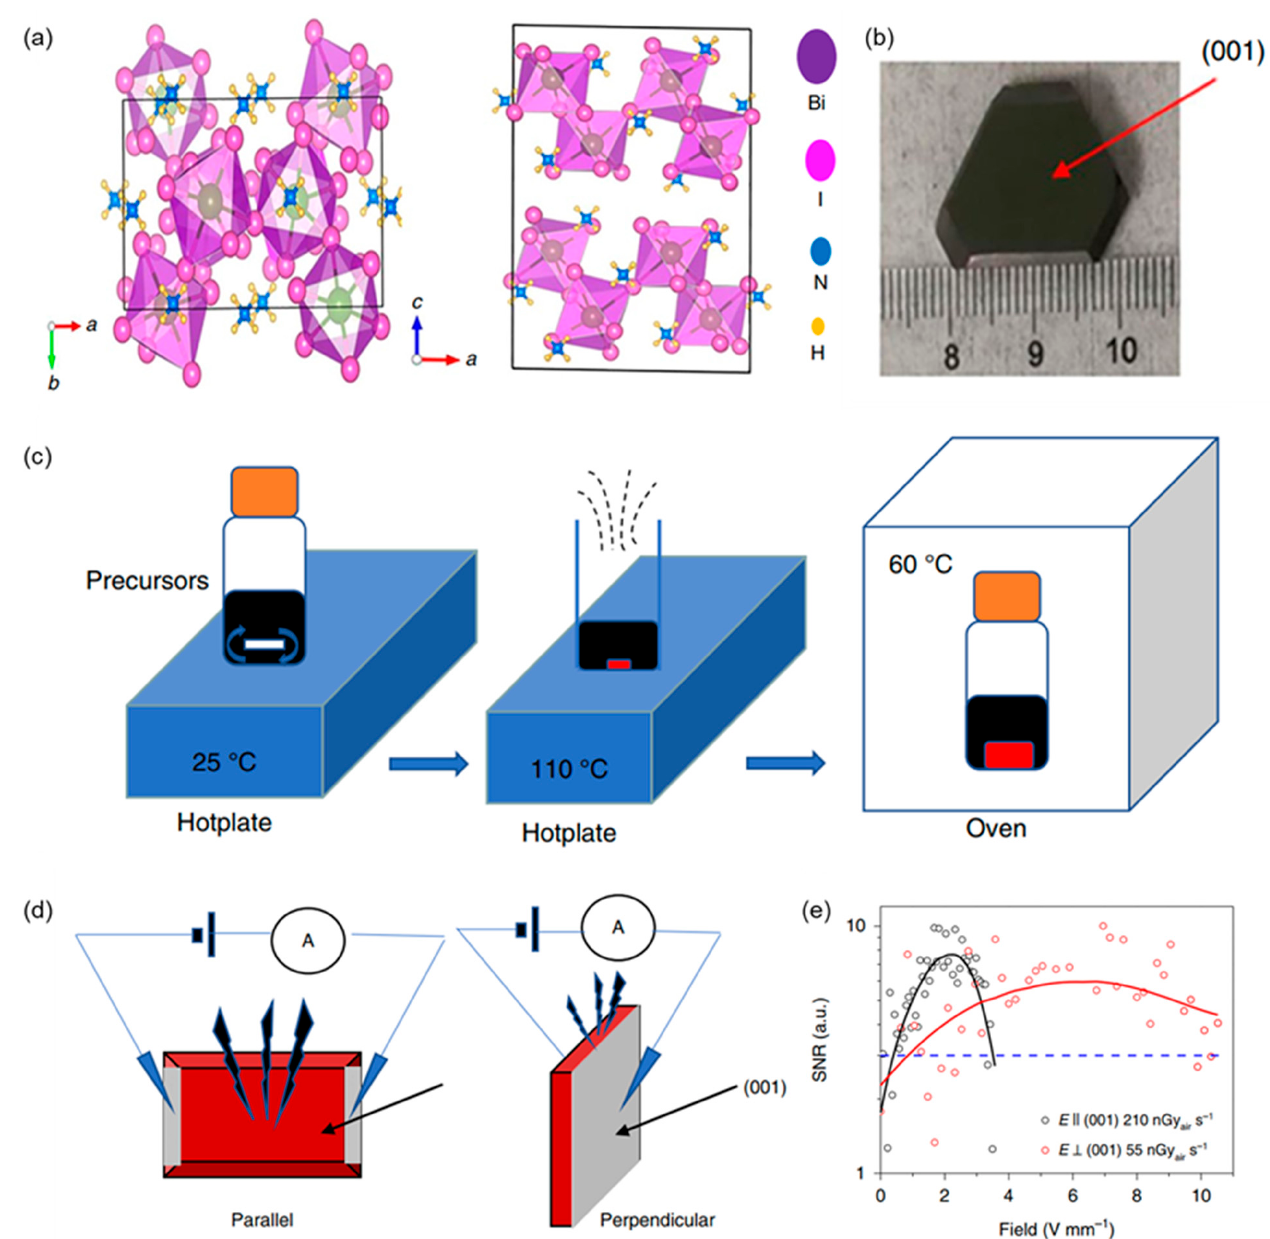
Figure 6. Low-dimensional organic–inorganic hybrid perovskites-based X-ray detectors. Reprinted with permission from Ref. [56]. 2019, Springer Nature. ( a ) Crystal structure of (NH 4 ) 3 Bi 2 l 9 along the c and b axes. ( b ) Photograph of a bulk (NH 4 ) 3 Bi 2 I 9 single crystal. ( c ) Procedure for crystal growth. ( d ) Illustration of parallel and perpendicular device structures. ( e ) The signal-to-noise ratio of the device in directions parallel to and perpendicular to the (001) surface. The dashed blue line indicates a signal-to-noise ratio of 3, so the detection limits are 210 nGy air s − 1 for parallel devices and 55 nGy air s − 1 for vertical